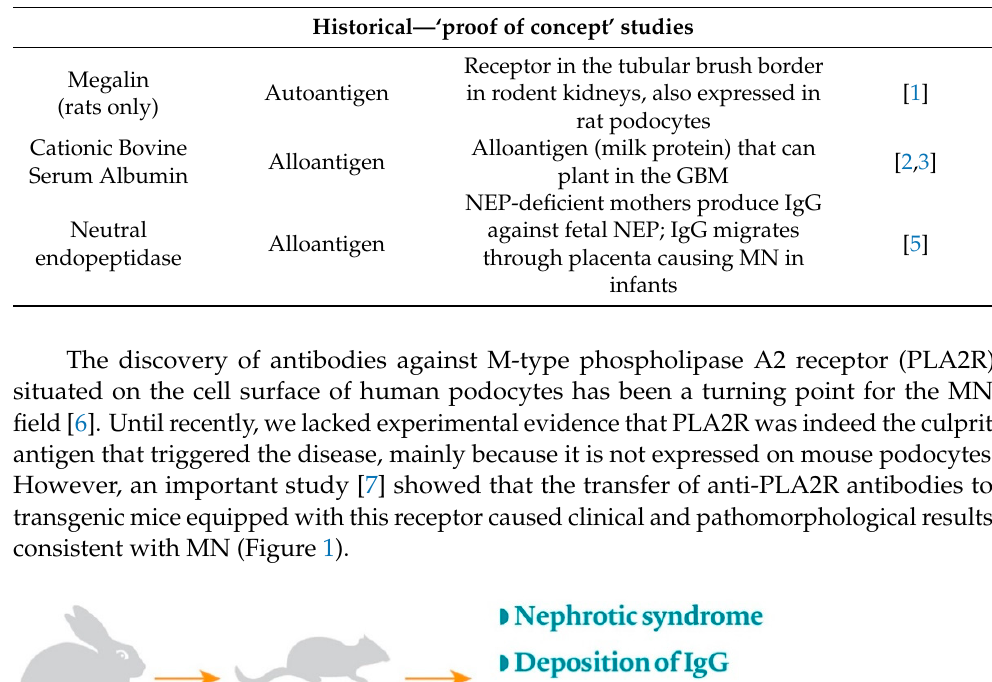
Figure 1. A study by Meyer-Schweinger and Tomas proved that antibodies against phospholipase A2 associated receptor 1 (PLA2R) cause primary membranous nephropathy. Immunoglobulin G (IgG).